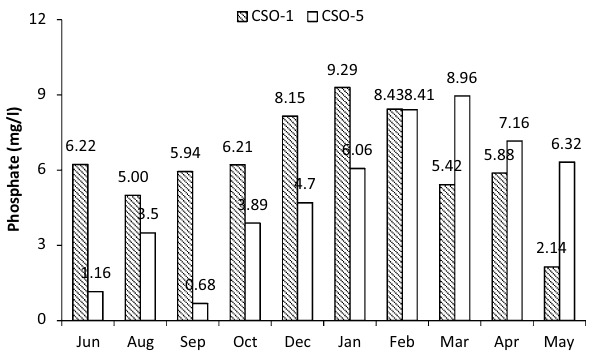
Fig. 10 Variation of phosphate (as PO 43− , mg/l) at different sam- pling times at the sampling locations close to CSO-1 and CSO-5. Overflows took place through CSO-1 during wet season (June to October), while there were no overflows through